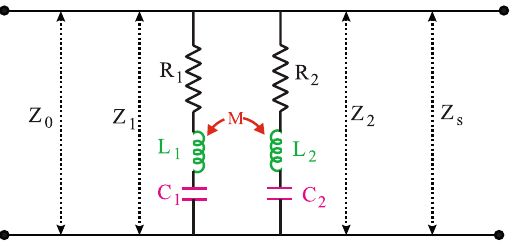
Figure 6. Schematic of TL-RLC circuit model. The circuit components R 1 , L 1 , C 1 represent resistance, inductance and capacitance related to lower order resonance and R 2 , L 2 , C 2 represent the same related to higher order resonance. M is the mutual inductance, responsible for coupling between resonances. Z 1 and Z 2 are impedances due to two circuits, respectively whereas Z 0 and Z S represent impedances of free space and silicon substrate, respectively.